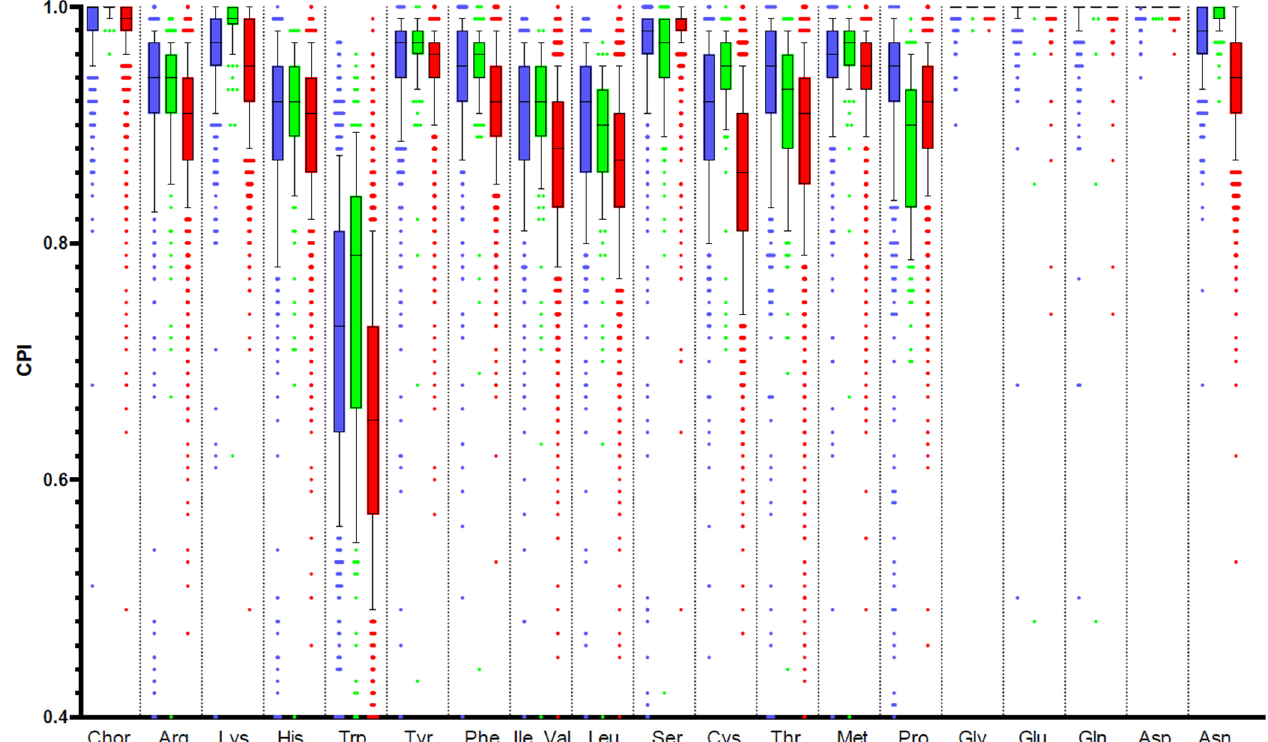
Figure 4. Distribution of Community Phenotype Indices (CPIs) for amino acid biosynthesis pathways in HGM samples. Samples from the AGP, UKT, and Hadza datasets are shown in blue, red, and green,